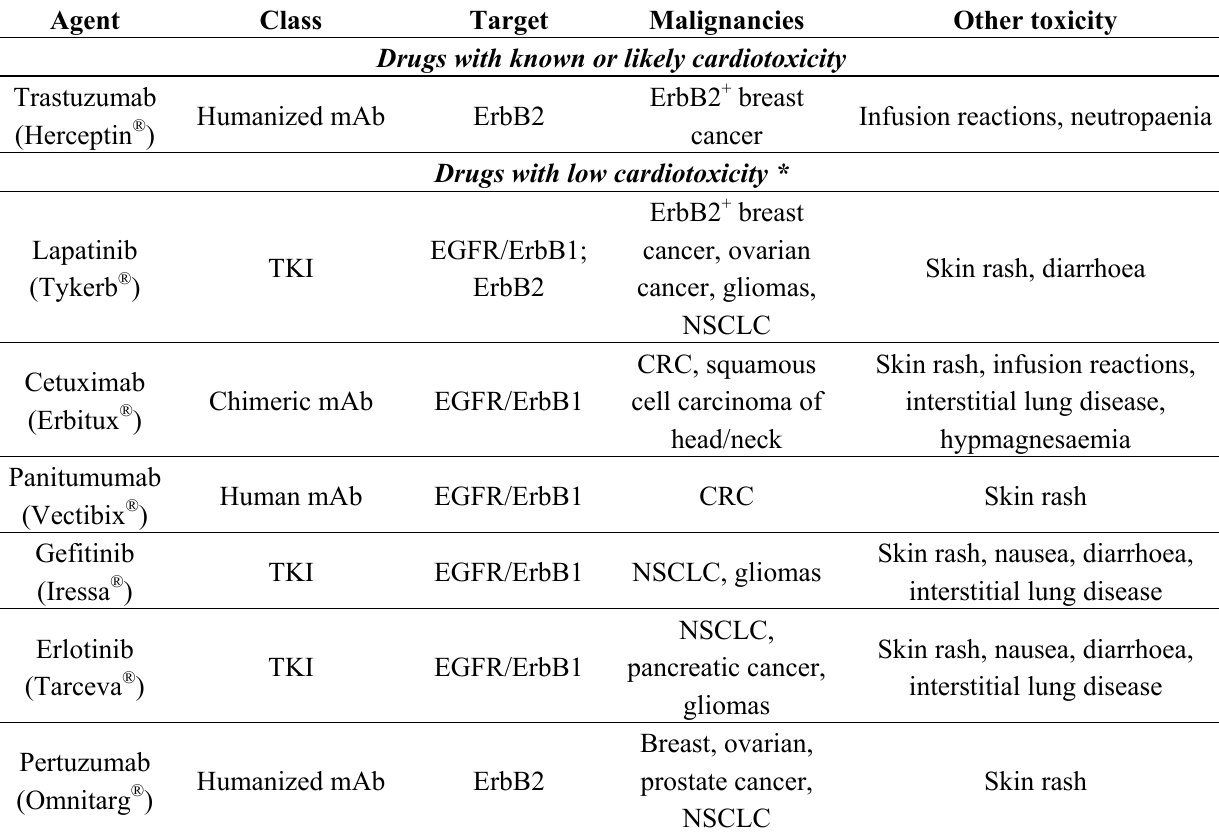
Table 1. Cardiotoxicity of ErbB-targeted